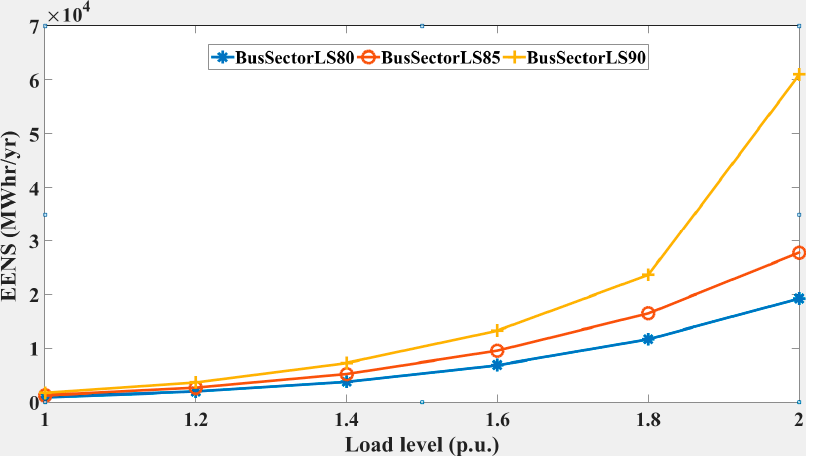
Figure 9. The EENS of BusSectorLS measures with increasing load levels.